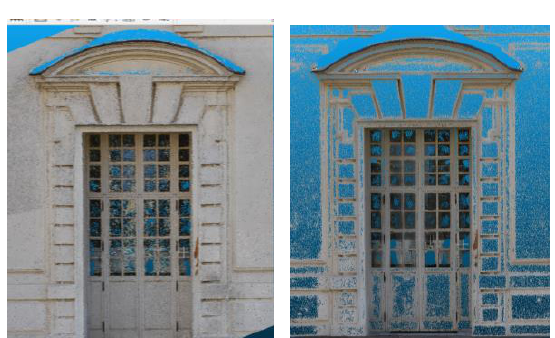
Figure 5. Point cloud generated using Photoscan (left) and Recap (right)